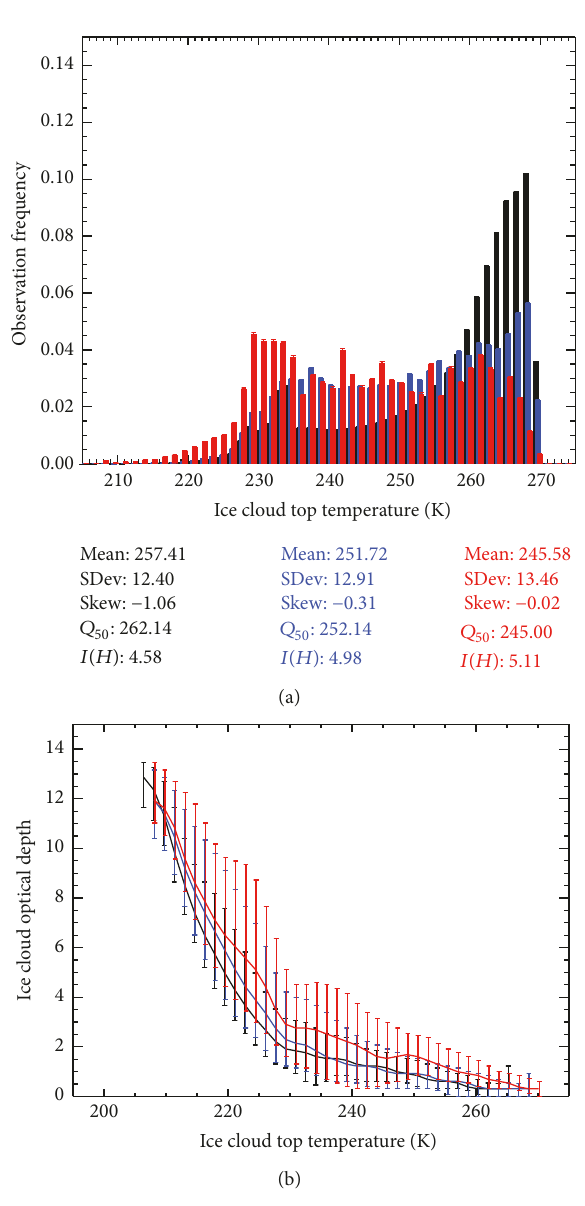
Figure 4: Ice cloud top temperature histograms 𝐻( CTT ) (a) and joint PDFs between CTT and ice cloud optical depth, 𝐻( CTT | COD ) (b), for all three dust loading subsets (in three colours for the three dust loading classes). The CTT histograms for the three dust loading classes are accompanied by the set of statistical descriptors. The joint PDFs are depicted as median value (solid line) and 25th and 75th percentile (bars) for each CTT bin. Black represents pristine background conditions, blue moderate dust loading, and red the high dust loading